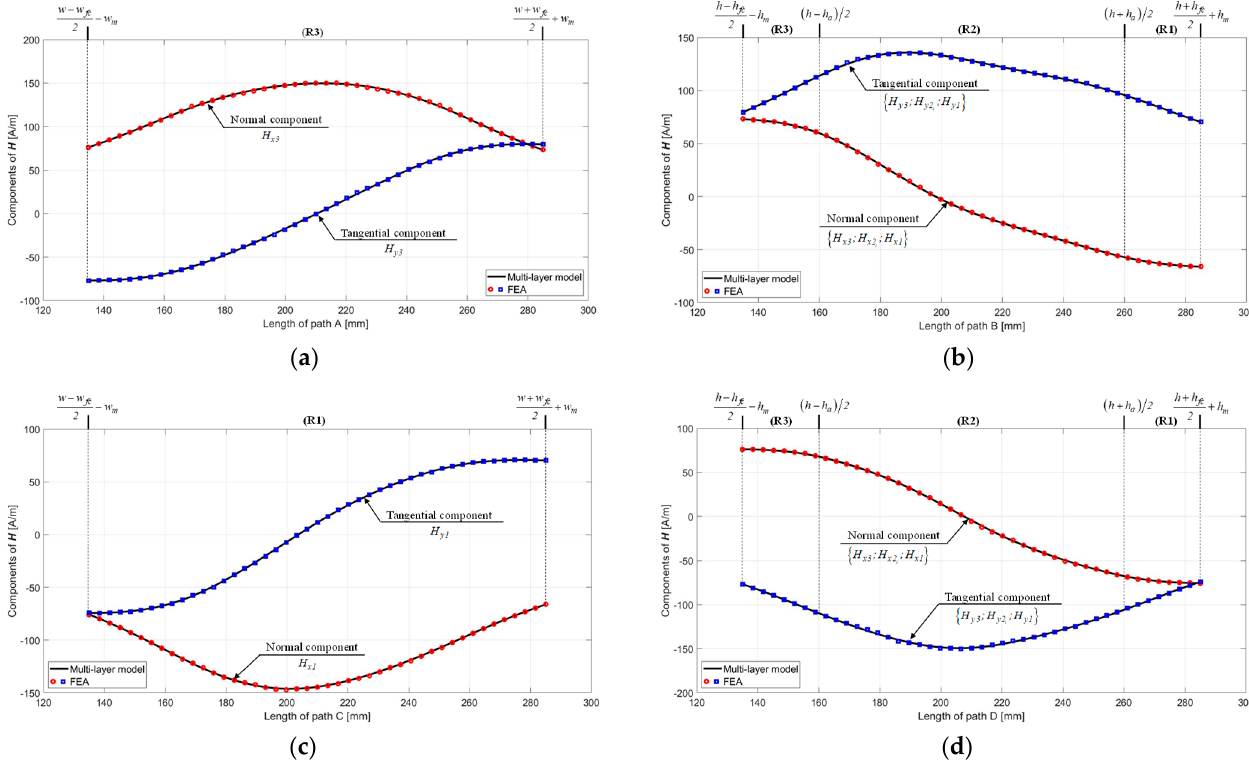
Figure 12. Components of H for an FC failure calculated by the 2D multi-layer model and verified by